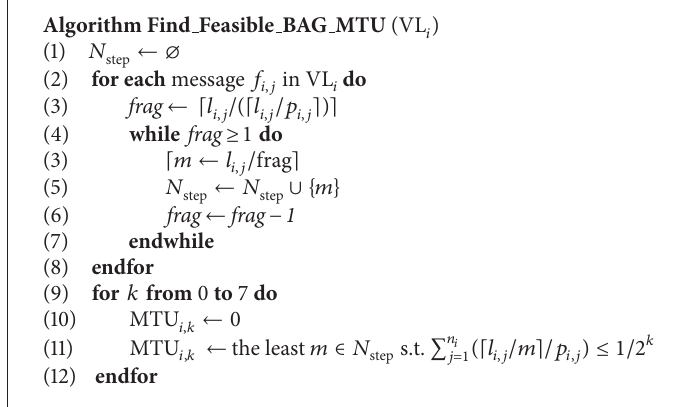
Algorithm 1: Algorithm of feasible BAG and MTU pairs of a VL.